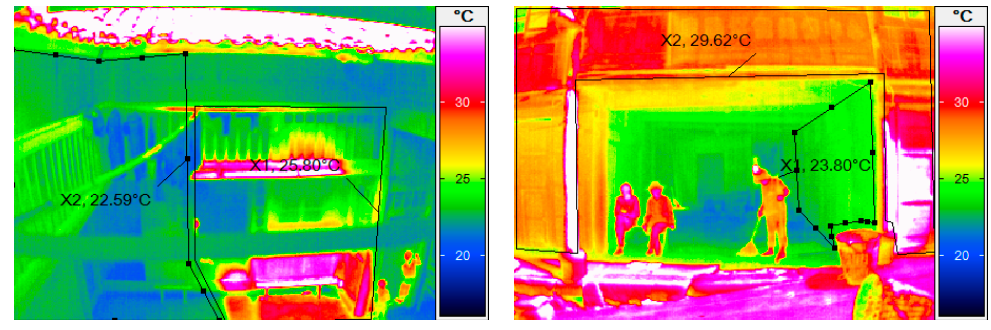
Figure 18. Thermographs of the courtyard in summer.